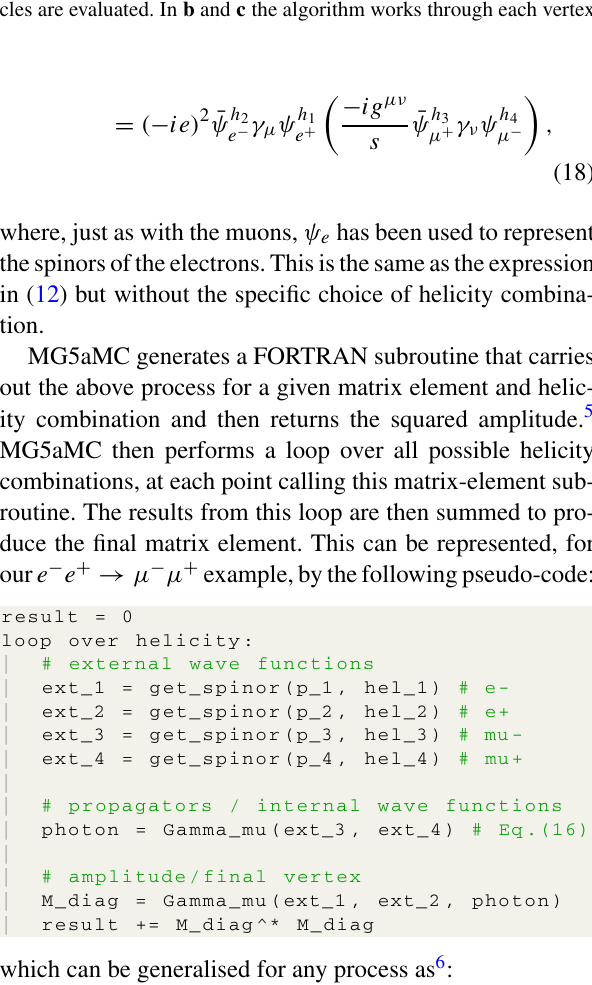
(circled), evaluating the wave function of the associated propagator (in red). Finally in d the last vertex is reach at which point the algorithm uses what it has calculated so far to evaluate the